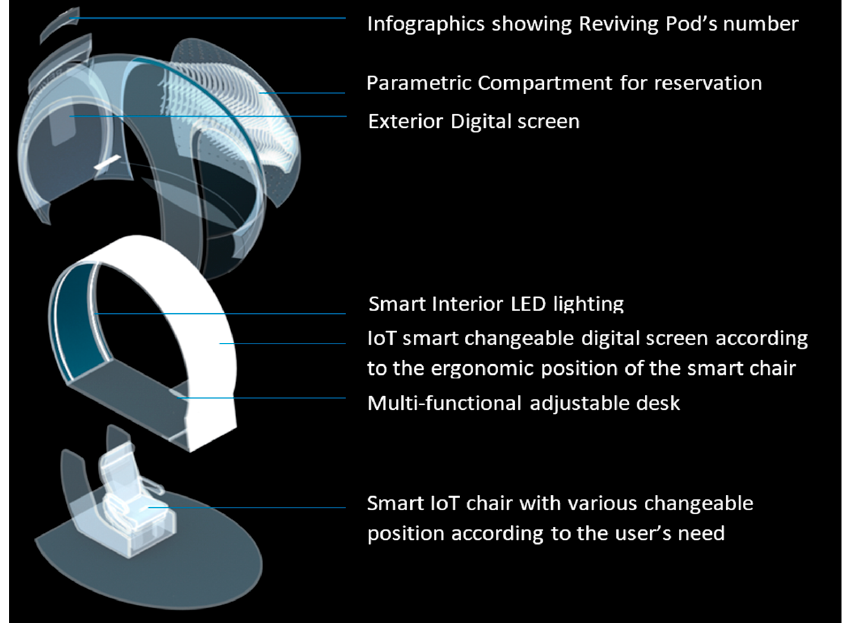
Figure 7. Exploded isometric illustrating the pod’s form, components, and interior design elements (designed by the authors).